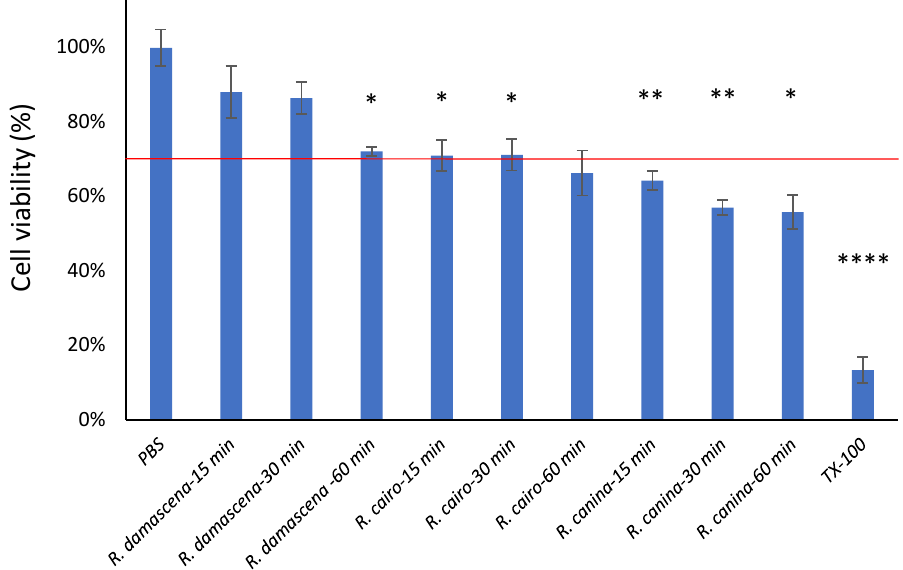
Figure 2. Cytotoxicity of different Rose SNEDDS samples on HaCaT cell line. Results of MTT assay of SNEDDS samples. Rosa damascena and Rosa cairo SNEDDS does not affect the cell viability because values are above 70%, however Rosa canina has a cytotoxic effect as cell viability is decreased below 70%. The results present the mean of 6 wells ± SD. Statistical analysis happened with one way ANOVA and T-test. Significant differences are marked in the figures with asterisks. * indicates significant differences at p = 0.0156; 0.0478; 0.0486; 0.0137. ** means significant differences at p = 0.0090; 0.023. **** means significant difference at p < 0.0001. The red line marks 70% of cell viability value, which is the recommendation of ISO 10993-5.